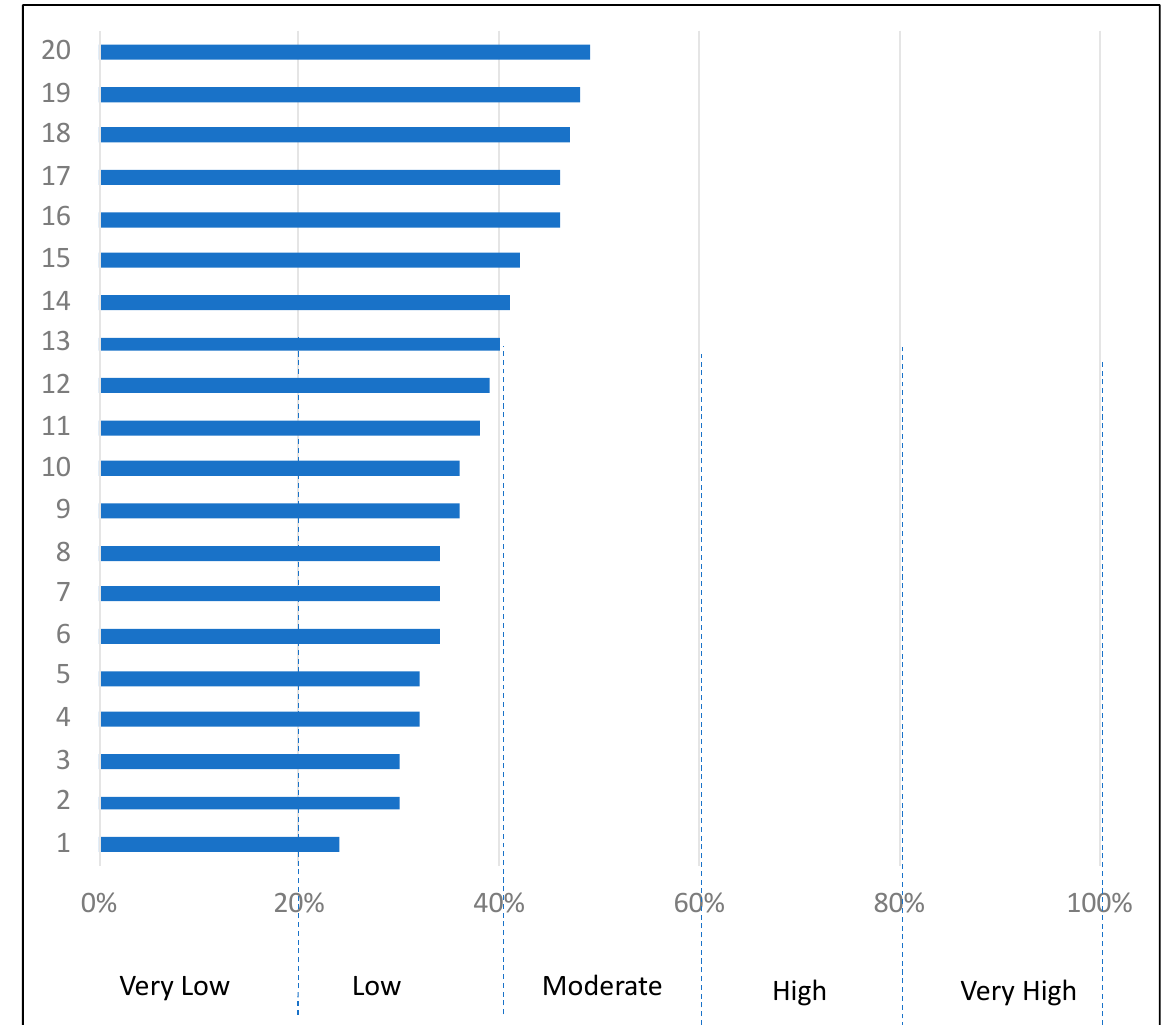
Figure 3. Percent final scores and level of holistic features.